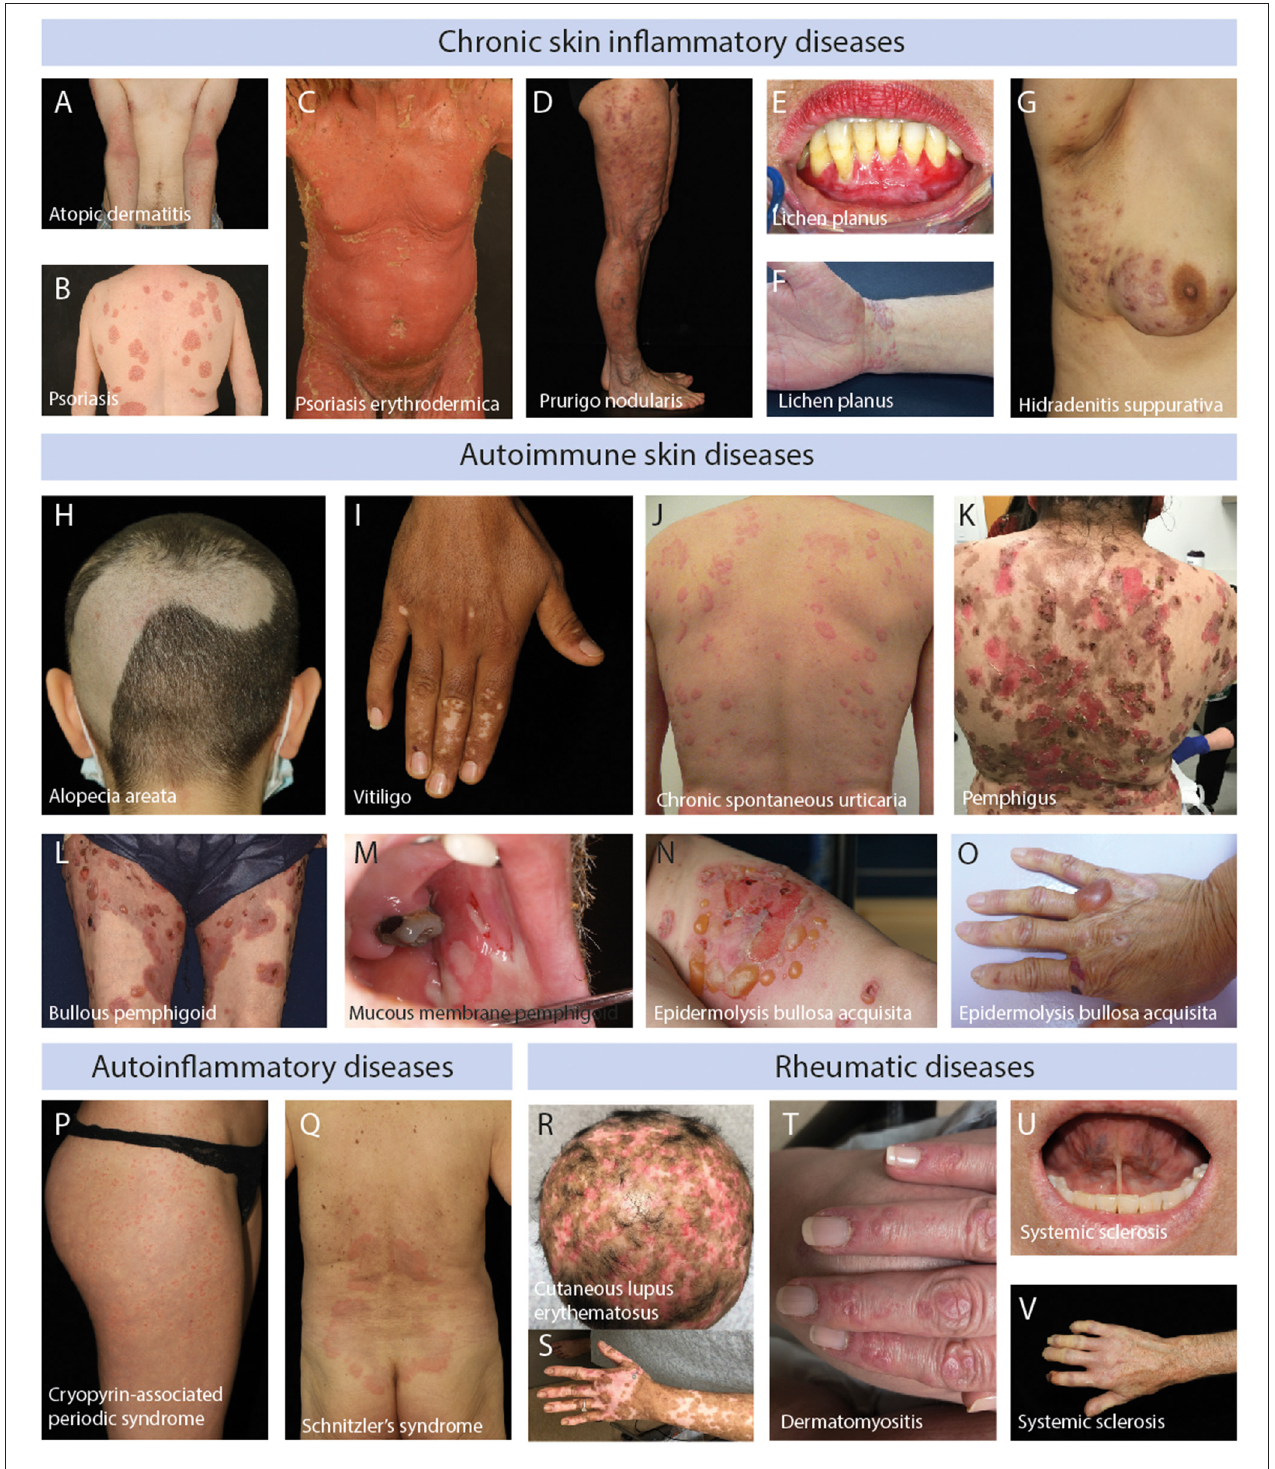
FIGURE 1 | Clinical images of patients with chronic skin inflammatory diseases. (A) Blurry erythema and lichenification at the inside the bend of the elbows and arms of a patient with atopic dermatitis. (B) Sharply demarked, scaling, erythematous plaques at the back of a patient with psoriasis vulgaris. (C) Generalized erythema and scaling in a patient with psoriasis. (D) Erythematous nodules, partially excoriated, in a patient with prurigo nodularis. (E) Erosions of the lower gums in a patient with mucosal lichen planus. (F) Polygonal, scaling, reddish-violet plaques at the wrist of a patient with cutaneous lichen planus. (G) Scaring, nodules and pustules located at the sub-axillary region of a patient with hidradenitis suppurativa. (H) Sharply demarked hair loss at the back of the head in a patient with alopecia areata.